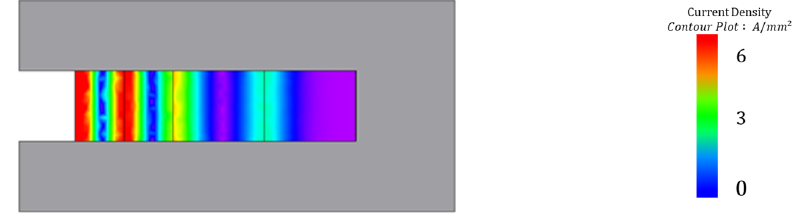
Figure 3. Slot-level current density contour plot of asymmetric four-layer conductors (80 Apk, 2 kHz).